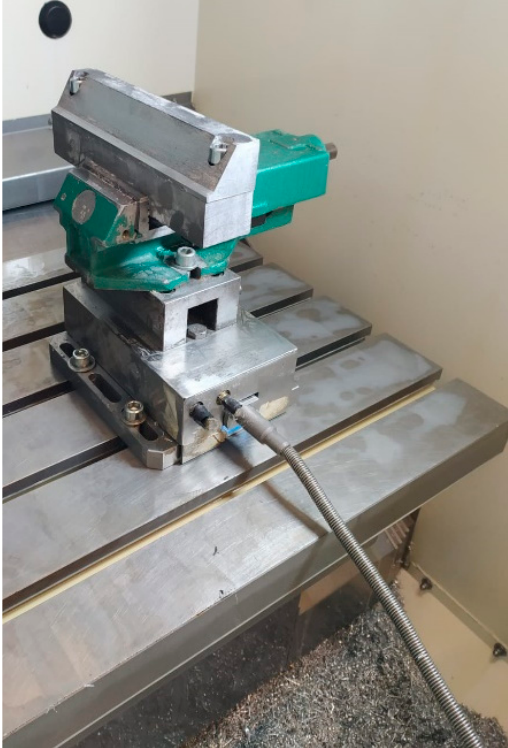
Figure 3. Fixture for mounting CFRP sample on the experimental device—piezoelectric dynamometer KISTLER 9265 B.